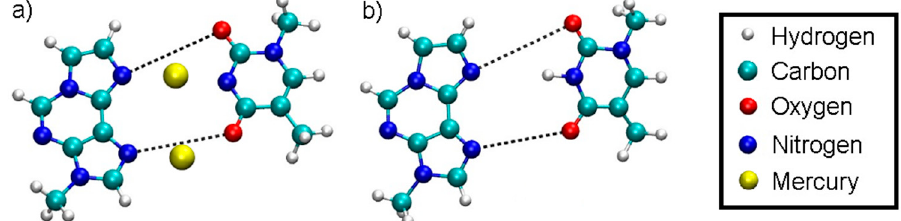
Figure 1. Definition of the dynamic distance within the plane of the modified base pair with Hg ( a ) and without Hg ( b ). The dynamic distance within the plane of the isolated base pair is defined in the same way as for the complete DNA duplex.